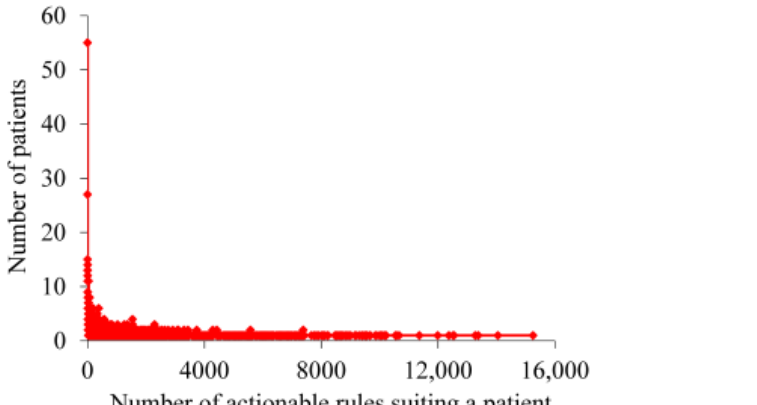
Figure 2. The patient distribution by the number of actionable rules suiting a patient for the patients with asthma whom our Kaiser Permanente Southern California model correctly forecasted to undergo asthma-related hospital visits in the succeeding year.